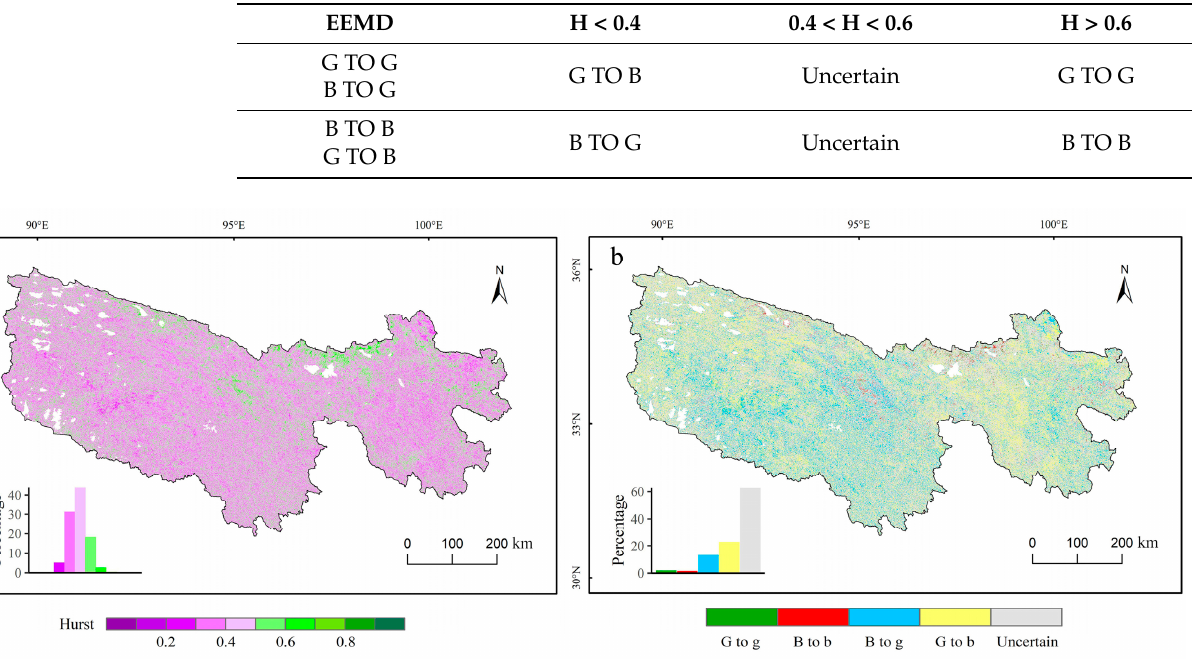
Figure 7. Spatial distributions of the Hurst exponent ( a ) and future vegetation projections ( b ).